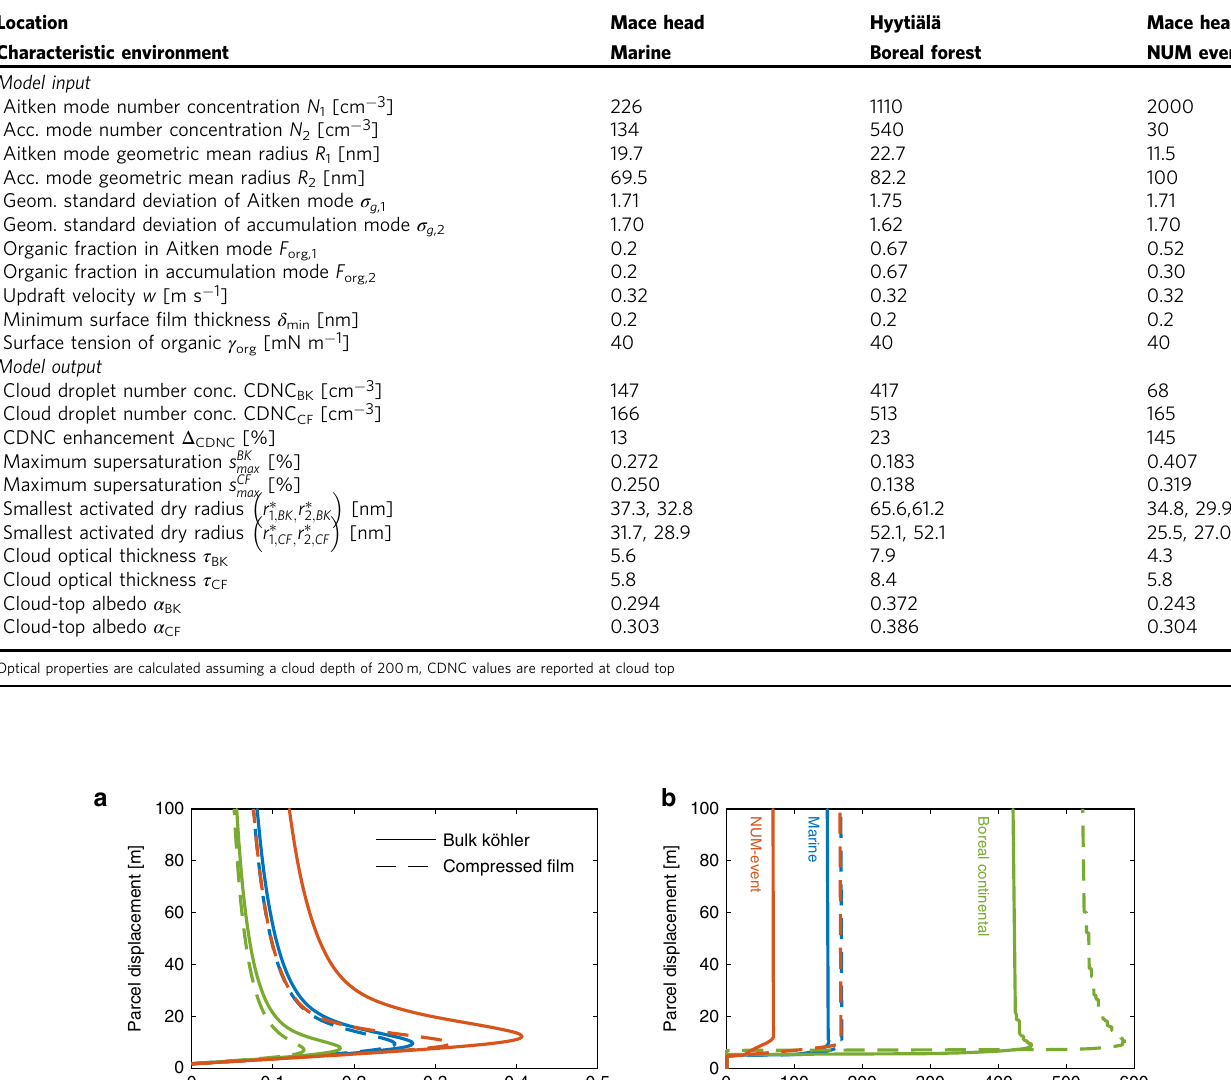
Table 1 Overview of parcel model input parameters and output variables for bulk Köhler (BK) and compressed fi lm (CF) models Location Characteristic environment